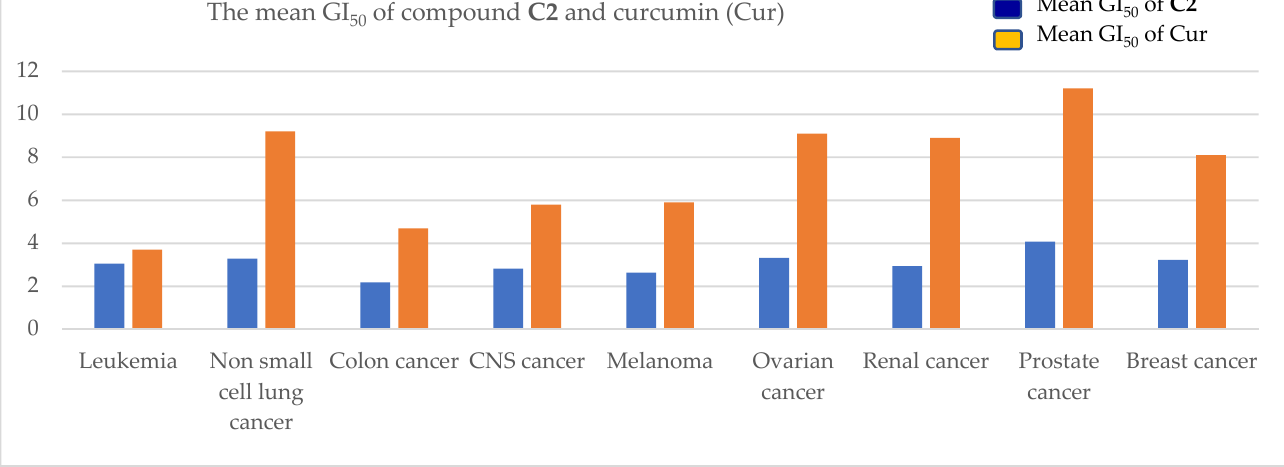
Figure 4. The mean GI 50 for compound C2 and curcumin (Cur) in µM concentration.